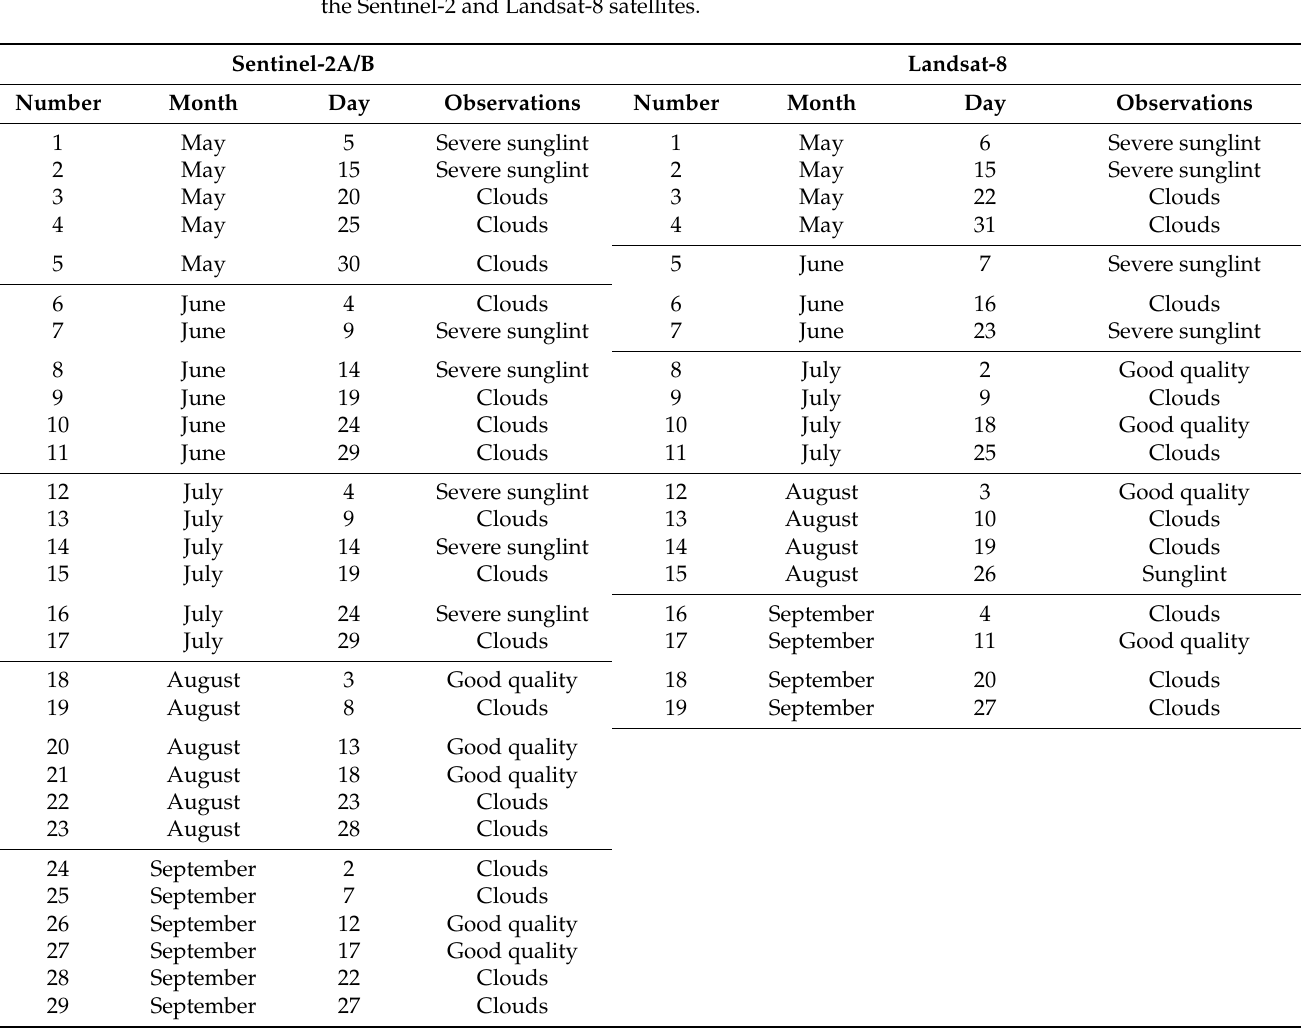
Table 1. List of imagery used in this study during the latest ecological crisis in 2021 corresponding to the Sentinel-2 and Landsat-8